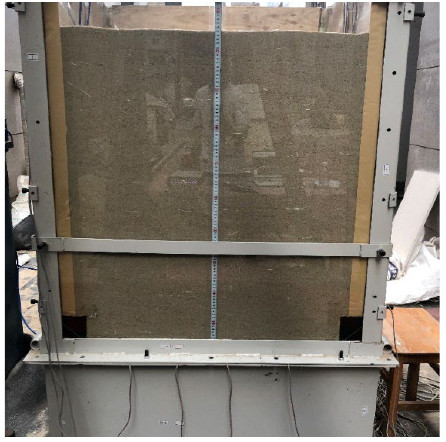
Figure 5. The filling of model